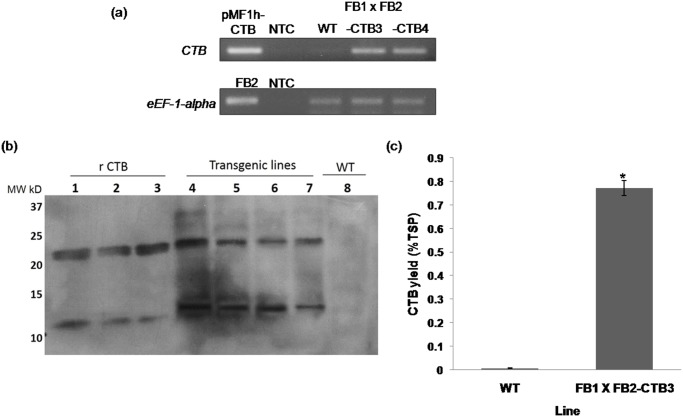

V. Cholerae CTB gene is successfully expressed in corn smut galls (‘huitlacoche’).Corn cobs were inoculated with the crosses FB1 x FB2-CTB 3 and FB1 x FB2-CTB 4, and FB1 x FB2 as control. (a) Expression analysis of the CTB gen in ‘huitlacoche’by semi-quantitative RT-PCR. Total RNA was isolated from fresh WT or transgenic corn smut galls (teliospores). Genomic DNA from U. maydis FB2 strain, the plasmid pMF1h-CTB, and a sample without template (NTC), were used as control. (b) Detection of the CTB protein in corn smut galls protein extracts by Western Blot analysis. Protein extracts were subjected to SDS PAGE under reducing conditions, blotted, and then labelled with an anti-CTB serum. Lanes 1 to 3, pure CTB standard (500, 250, and 100 ng, respectively); 4 and 5, extracts from ‘huitlacoche’ produced with the FB1 x FB2-CTB3 cross; 6 and 7, ‘huitlacoche’ produced with the FB1 x FB2-CTB 4 cross; and 8, extract from WT ‘huitlacoche’ (FB1 x FB2). (c) Quantification of CTB levels in terms of %TSP by GM1-ELISA assay. Oligomeric CTB was detected in total soluble protein extracts from either FB1 x FB2-CTB 3 galls or WT galls followed by immunodetection with an anti-CTB serum. The Asterisk denotes statistical differences at P< 0.05 versus WT galls.